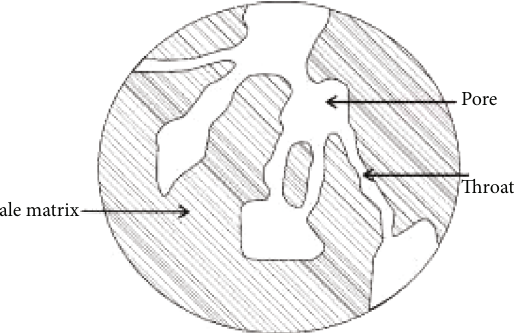
Figure 6: Schematics of ink-bottle